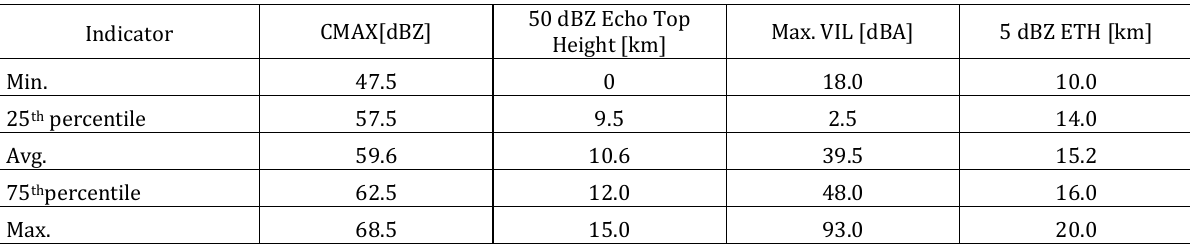
Table. 2 Selected radar echo characteristics within the 62 analysed hailstorms in Poland in 2007 –